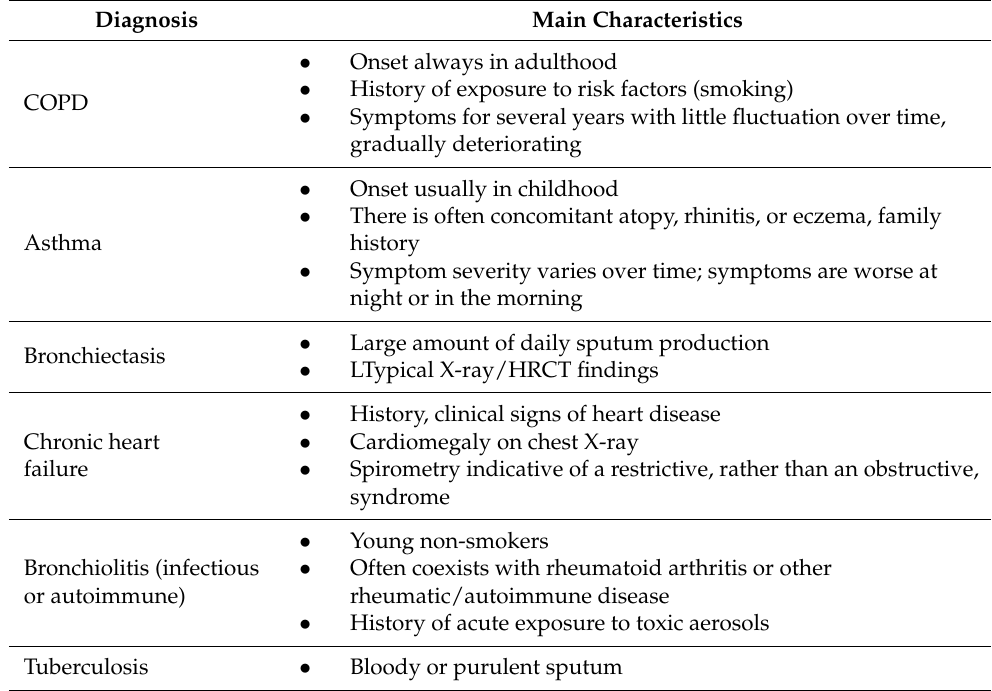
Table 1. Differential diagnosis of